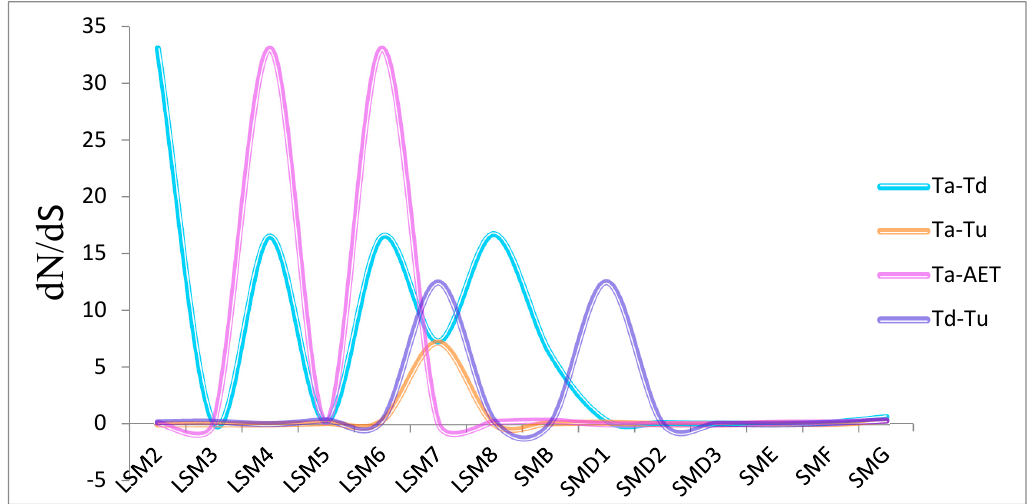
Figure 2. Non-synonymous to synonymous (dN/dS). The dN/dS ratios for orthologous SSM/SLSM genes between wheat and its relatives. The blue line represents the dN/dS ratios between SSM/SLSM genes of wheat and Triticum dicoccoides . The orange line represents the dN/dS ratios between SSM/SLSM genes of wheat and Triticum urartu . The pink line represents the dN/dS ratios between SSM/SLSM genes of wheat and Aegilops tauschii . The purple line represents the dN/dS ratios between SSM/SLSM genes of Triticum dicoccoides and Aegilops tauschii .